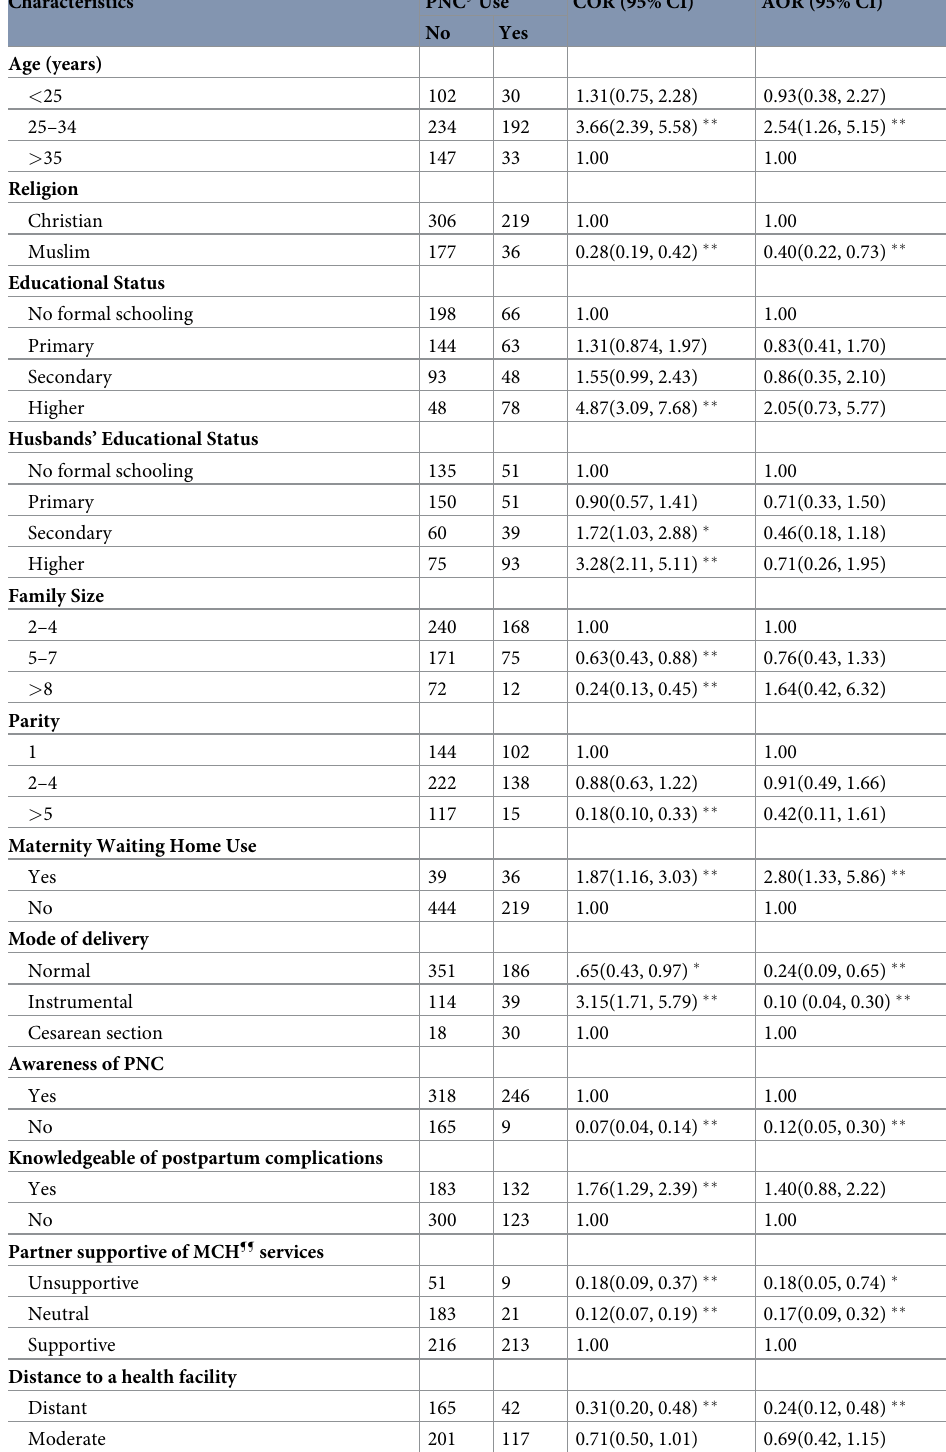
Table 3. Factors associated with postnatal care service utilization.